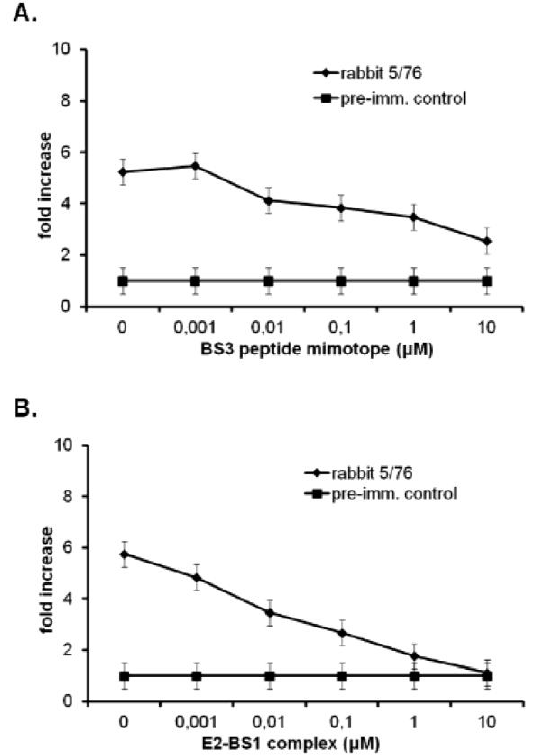
Figure 4. Displacement of m-gp120 SF162 binding. A competitive ELISA assay was performed to analyze the specificity of rabbit immune response against m-gp120 SF162. Rabbit serum 5/76 and its relative pre-immune serum as negative control were incubated with the same increasing molar concentration of BS3 peptide mimotope ( A ) and E2-BS1 complex ( B ). Data were reported as the fold increase of rabbit 5/76/pre-immune serum ratio. The statistical significant was evaluated as the difference in binding displacement between BS3 and E2-BS1, and assessed by performing a standard Student’s t test ( p < 0.05). Error bars were